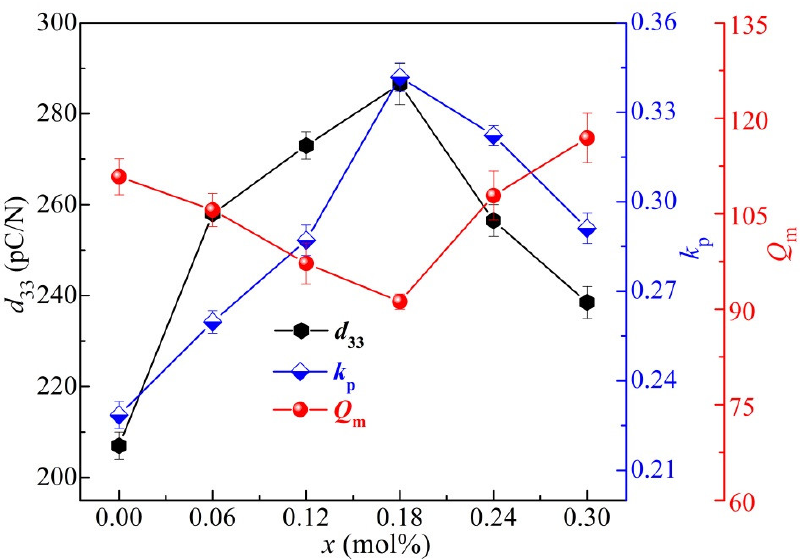
Figure 9. Mechanical quality factor ( Q m ), planar vibration electromechanical coupling factors ( k p ), and piezoelectric constant ( d 33 ) of the BCTZ-NY x ceramics.